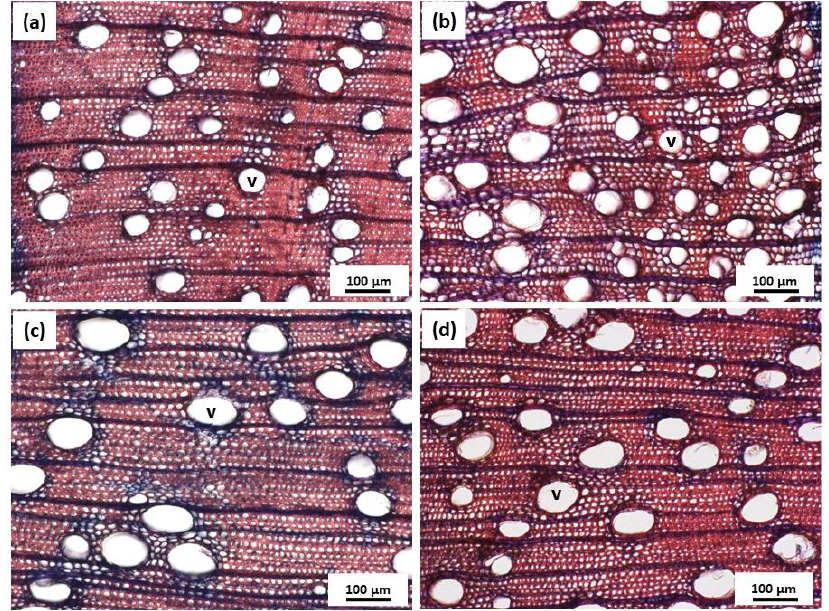
Figure 6. Vessel distribution of well-watered Eucalyptus grandis at ( a ) ambient CO 2 and ( c ) elevated CO 2 ; and drought-stressed Eucalyptus grandis at ( b ) ambient CO 2 and ( d ) elevated CO 2 . V marks the vessels exemplarily. Digital photograph was taken using AxioCam MRC, Zeiss axioskop 40, 10 ×